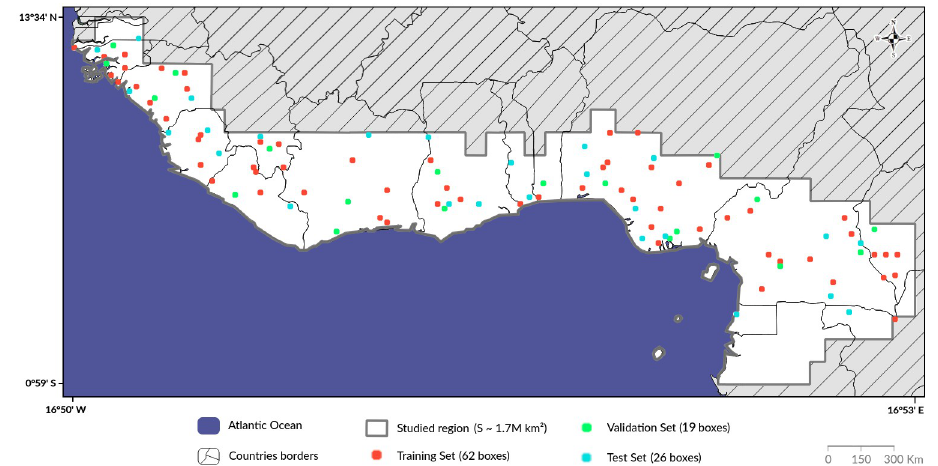
Fig 1. Studied region visualization. Mapping of the paper’s studied region (white) and presentation of the dispatched labeled dataset boxes, divided into training set (red), validation set (green) and test set (blue).